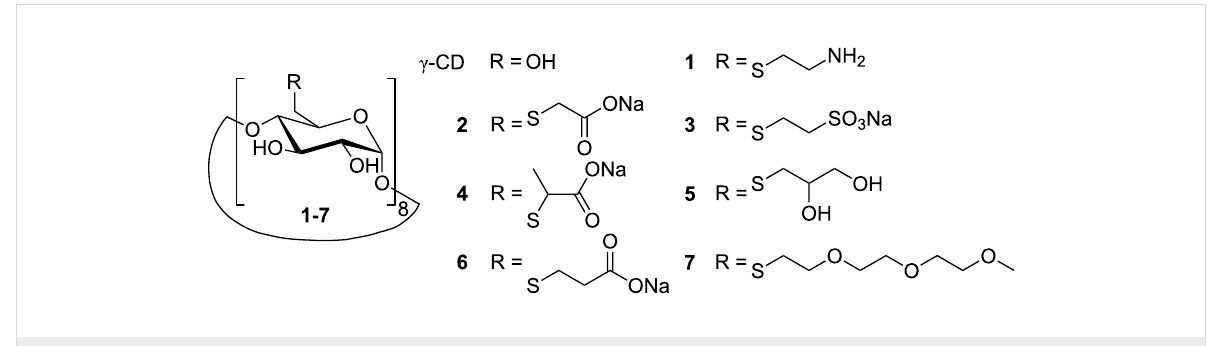
Figure 2: Structures of γ -CD and γ -CD thioethers 1 – 7 .